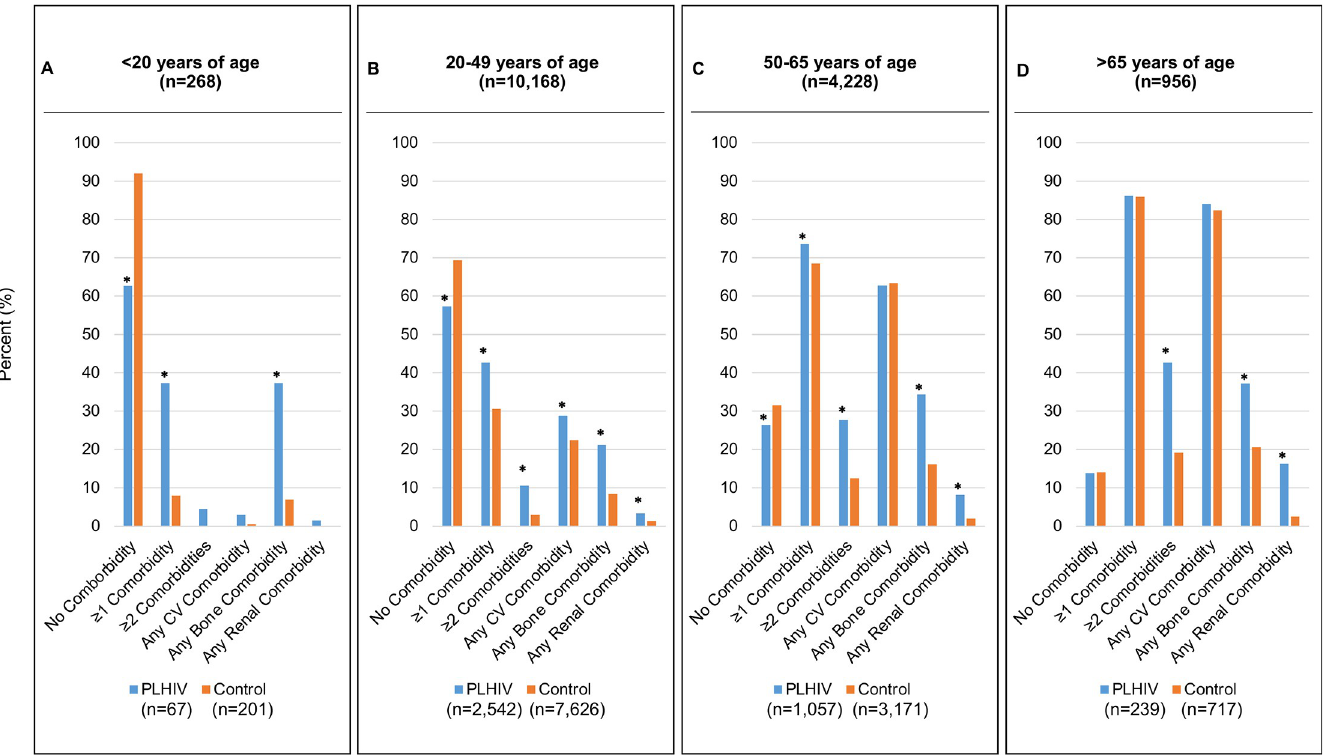
Fig 1. Distribution of comorbidities by type for different age groups of PLHIV and controls. (A) < 20 years of age, (B) 20–49 years of age, (C) 50–65 years of age, (D) > 65 years of age.